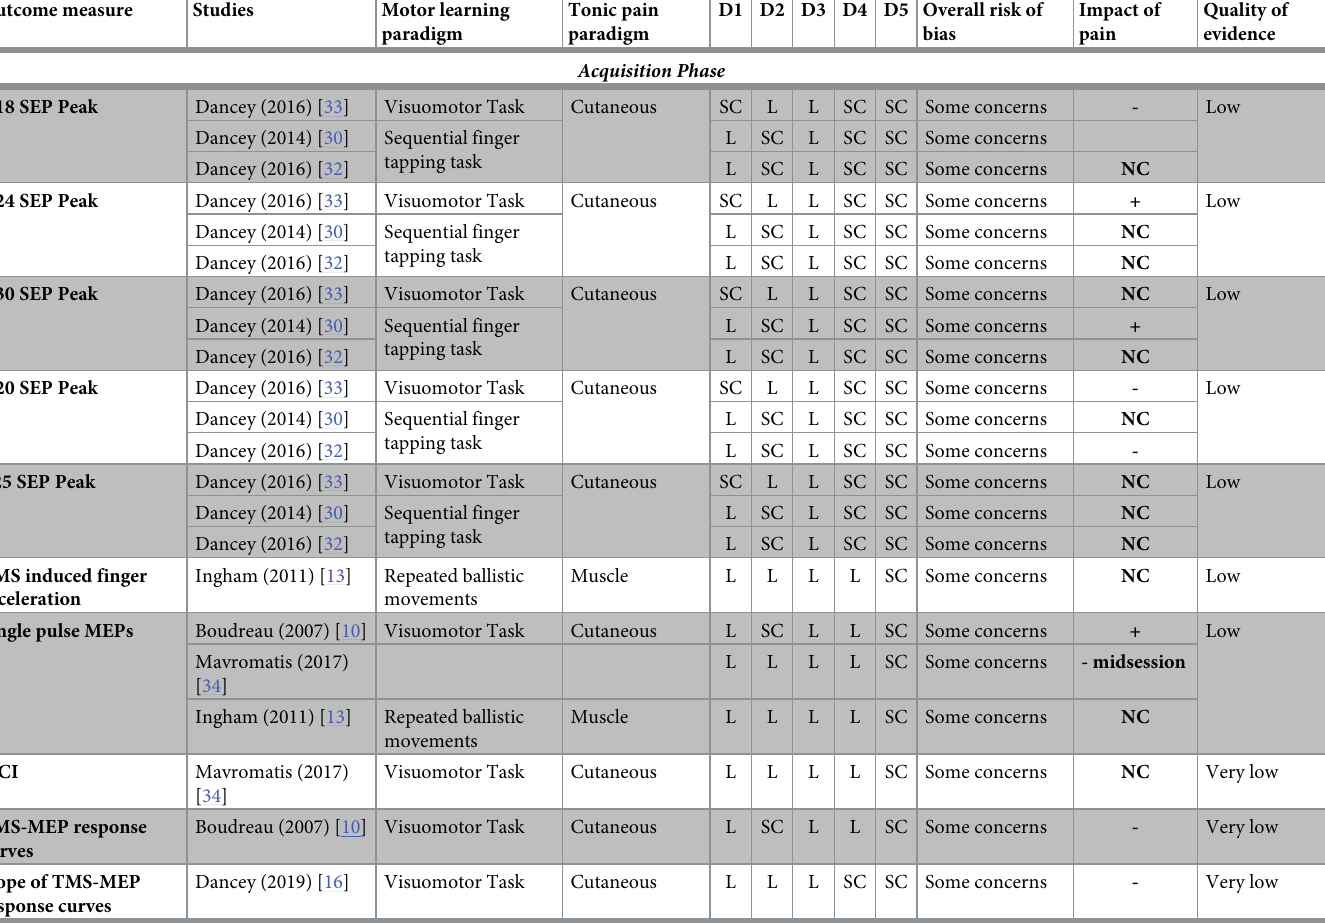
Table 5. Synthesis of evidence, risk of bias judgements and quality of evidence scores for the impact of tonic pain on individual activity dependent plasticity outcome. Outcome